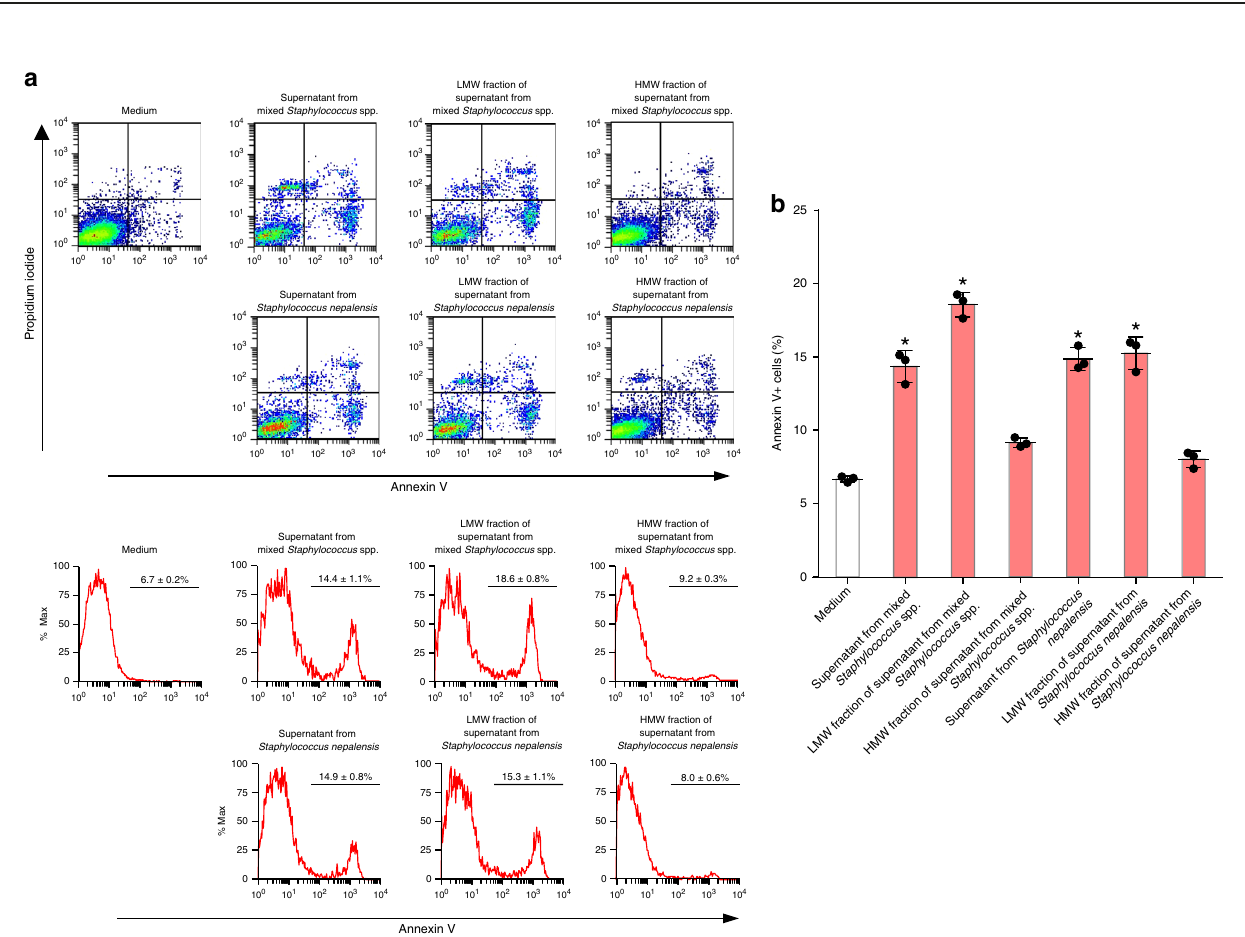
Fig. 4 The apoptotic factor in culture supernatant from bacteria is a low molecular weight protein. a , b Culture supernatant from bacteria was separated into fractions of <10 kDa and >10 kDa by fi ltration and each fraction was added to A549 alveolar epithelial cells after 1/10 dilution to determine apoptosis by fl ow cytometry. For each group, n = 3. Bars indicate the means ± S.D. Statistical analysis by ANOVA and Tukey ’ s test. * p < 0.001 vs medium control. LMW low molecular weight, HMW high molecular weight. The source data underlying b are provided in the Source Data fi Identi fi cation of the pro-apoptotic peptide . We next proceeded Figs. 6 and 7). The biological activity decreased signi fi cantly after to purify the soluble pro-apoptotic factor from the culture treatment of the samples with proteinase K (Supplementary supernatant of Staphylococcus nepalensis strain CNDG. Successive Fig. 8a, b). Silver staining, after gel electrophoresis of the sample, extractions of the proteins in the supernatant were performed in n - revealed a protein/peptide with an apparent molecular weight hexane, water, ethyl acetate, ethanol and then fractionations using of 2 kDa (Supplementary Fig. 9). Subsequently, we analyzed the- octadecyl-silane gel fl ash column chromatography and Sep-Pak peptide by mass spectrometry and compared the raw data followed by high-performance liquid chromatography (HPLC) against a custom database of Staphylococcus nepalensis strain (Supplementary Fig. 5; see HPLC data in Supplementary Infor- CNDG protein sequences, based on its closed genome sequence mation) to separate the biologically active protein (Supplementary data (Genbank Accession number PRJNA544423). The mass